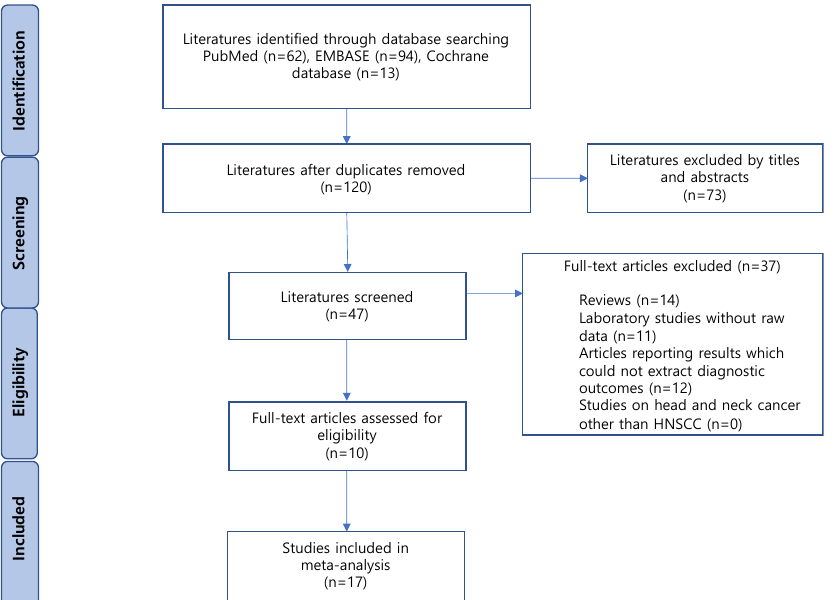
Figure 1. Flowchart. HNSCC; head and neck squamous cell